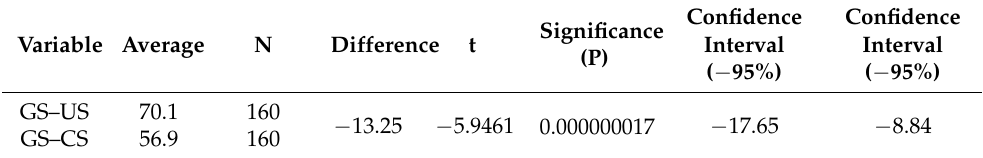
Table A1. Results of t-test for dependent samples. Variable Average Difference t